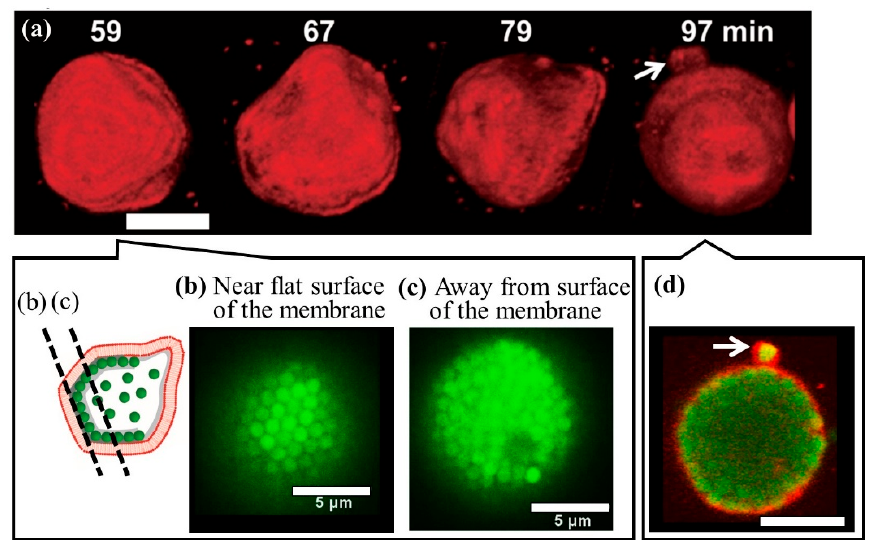
Figure 3. Temporal transition of an asymmetrical polyhedral vesicle at 59–97 min after the addition of hypertonic solution. ( a ) The deformation pathway of a vesicle with encapsulated polystyrene beads at 13 vol%. Scale bar, 5 μ m. ( b , c ) Behavior of the encapsulated polystyrene beads near or away from the flat surface of the vesicle membrane at 59 min; although the beads in ( b ) are organized in a crystallization pattern, no orderly bead array could be found in ( c ). ( d ) A tubular structure (white arrow) protruding from the polyhedral vesicle at 97 min. Moderate volume fractions of polystyrene beads play an essential role in this characteristic polyhedral deformation. The figure is modified from Figures 3 and 4 in [19].